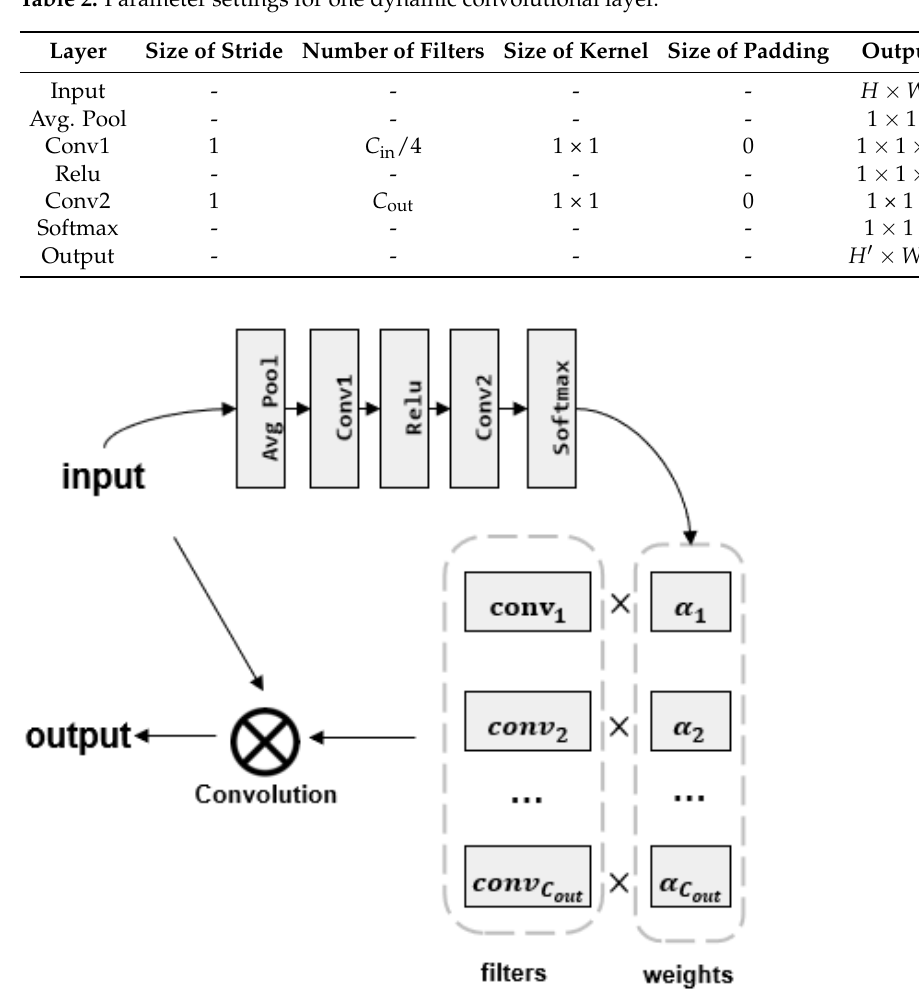
Figure 2. The overall framework of the dynamic convolutional